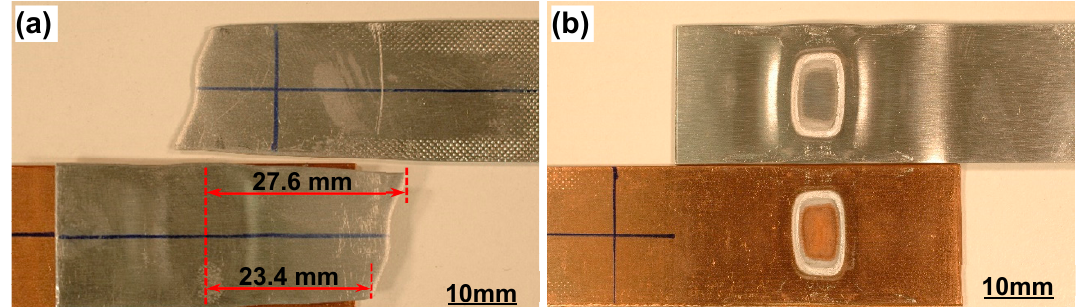
Figure 3. Typical fatigue failure modes of EMPWed Al-Cu lap joints: ( a ) Base metal fracture (BMF) or transverse through-thickness (TTT) crack growth at the maximum cyclic load of 3 kN, and ( b ) Interfacial failure (IF) at the maximum cyclic load of 1 kN.